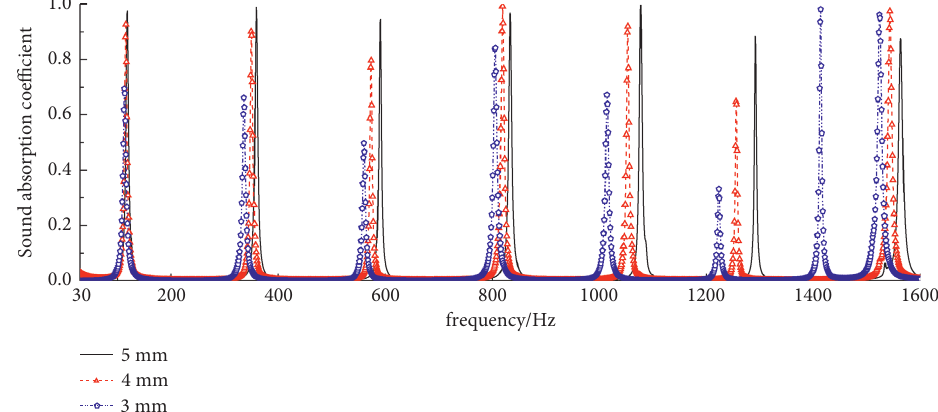
Figure 8: Sound absorption characteristics curves of metamaterials at different channel widths.